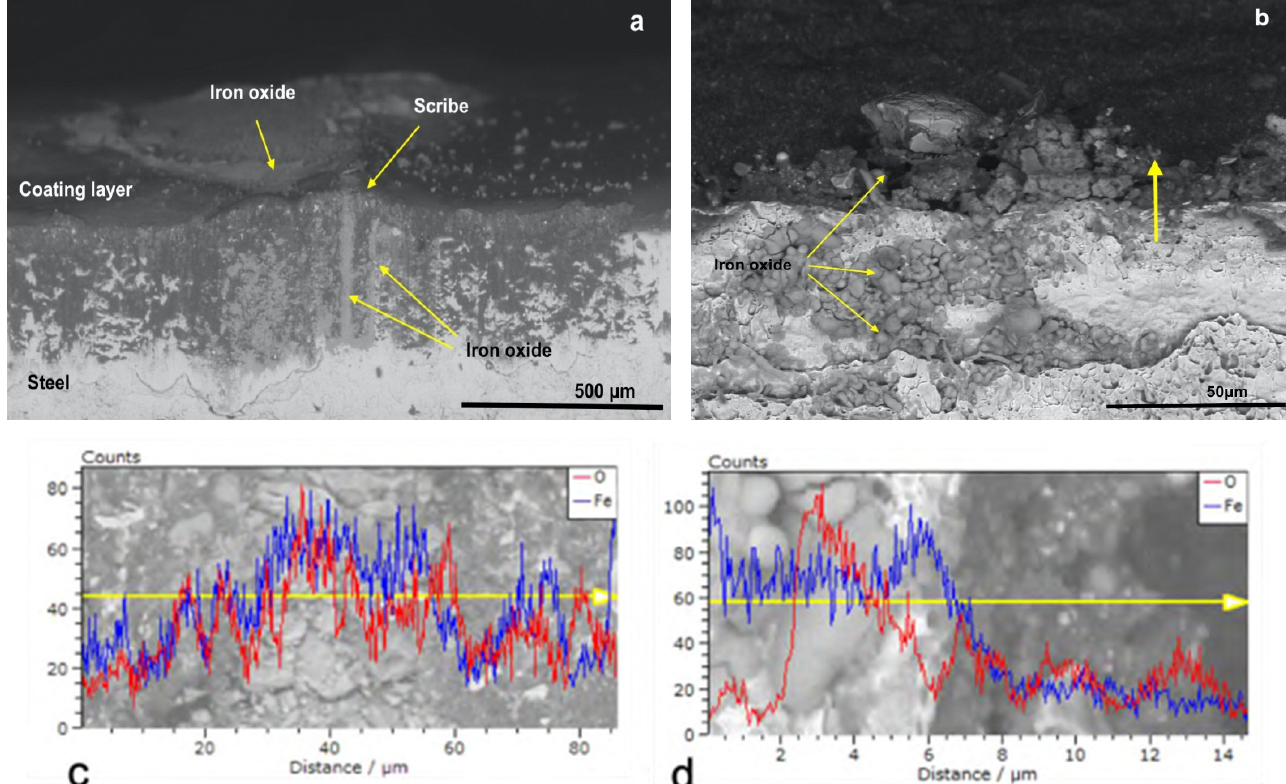
Figure 6. SEM micrographs with EDX linescan ( c , d ) of the cross-section of CB_0 U coated specimens at ( a ) the scribe and at ( b ) no-scribed region. Red and blue spectra correspond to O and Fe, respec- tively.